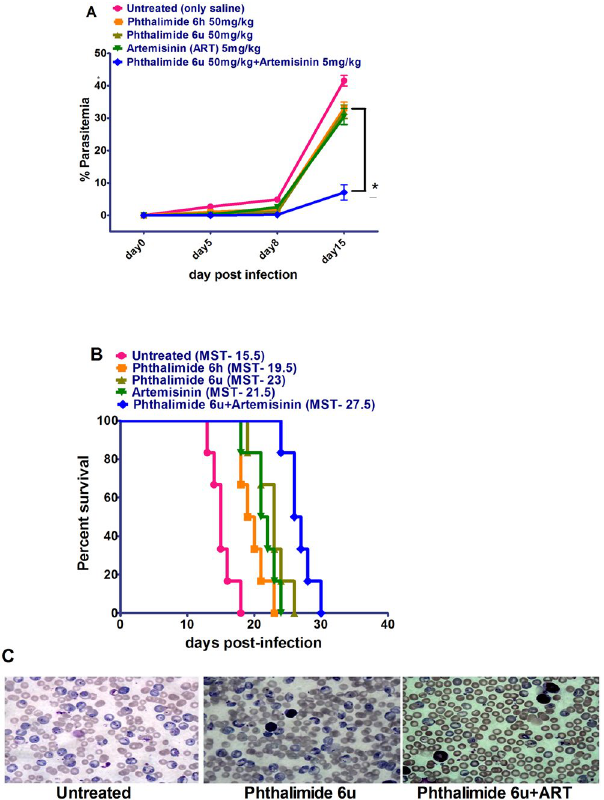
Figure 6. Antimalarial effect of Pht analogs ( 6h and 6u ) alone and in combination with Artemisinin ( 6u and ART) on parasitemia and survival in mice infected with P. berghei NK65. Mice were injected with 1 × 10 7 P. berghei infected RBCs. After 48 hours mice were treated with control (PBS : untreated ), 6h and 6u (alone), and 6u in combination with artemisinin (all injected subcutaneously) for four consecutive days. The % of parasitemia was determined for the groups on days 5, 8 and 15 by randomly selecting 10 different optical fields on blood smears. ( A ) Administration of 6h and 6u (alone), and 6 u in combination with ART. Data are the mean ± SEM from six animals per treatment group. ( B ) Survival in the treatment groups (n = 6/group). ( C ) Photomicrograph of blood smears of untreated versus treatment groups at day 15 post infection (100x magnification). ART, Artemisinin; * P <